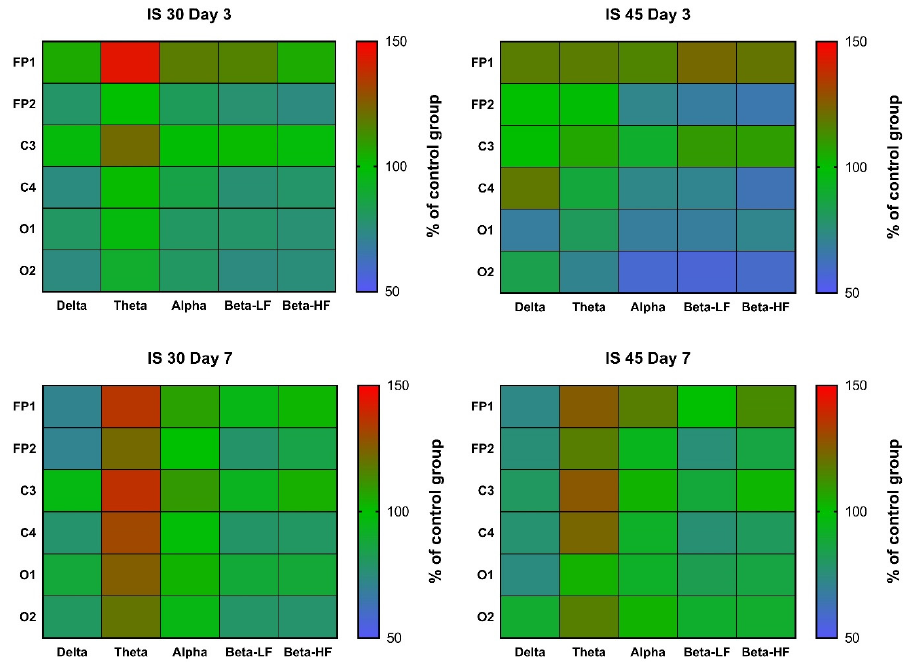
Figure 6. Heatmaps of mean power of δ , θ , α , high and low frequency β waves in channels FP1, FP2, C3, C4, O1, and O2 at post ‐ surgery days 3 and 7. Data were normalized to the respective control values ( n = 6). IS 30 ( n = 6) and IS 45 ( n = 6), groups subjected to cerebral ischemia for 30 and 45 min, respectively. Another important feature of ischemic brain injury in both IS 30 and IS 45 groups was a disruption of inter ‐ and intrahemispheric functional connectivity, as evidenced by decreased Ccr values for different electrode pairs (Figure 7, Tables S1 and S2). For exam ‐ ple, in IS 30 animals, a statistically significant ( p < 0.05 vs. Control) decrease in Ccr for electrode pair FP1 ‐ FP1 was seen at post ‐ surgery day 3. On day 7, no significant differences were found for IS 30 vs. Control. Quite unsurprisingly, longer ischemic exposure led to a more profound disruption of inter ‐ and intrahemispheric functional connectivity. Com ‐ pared to Control, IS 45 rats had lower Ccr for pairs FP1 ‐ FP2 ( p < 0.01), C3 ‐ C4 ( p < 0.05), and O1 ‐ O2 ( p < 0.05) at post ‐ surgery day 3, and for pairs FP1 ‐ FP2 ( p < 0.05) and C4 ‐ O2 ( p < 0.05) at day 7. No statistically significant differences were found between the two IS groups at day 3; however, at day 7, IS 45 had a lower Ccr value for channel pair C4 ‐ O2 than both the Control and IS 30 groups ( p < 0.05).